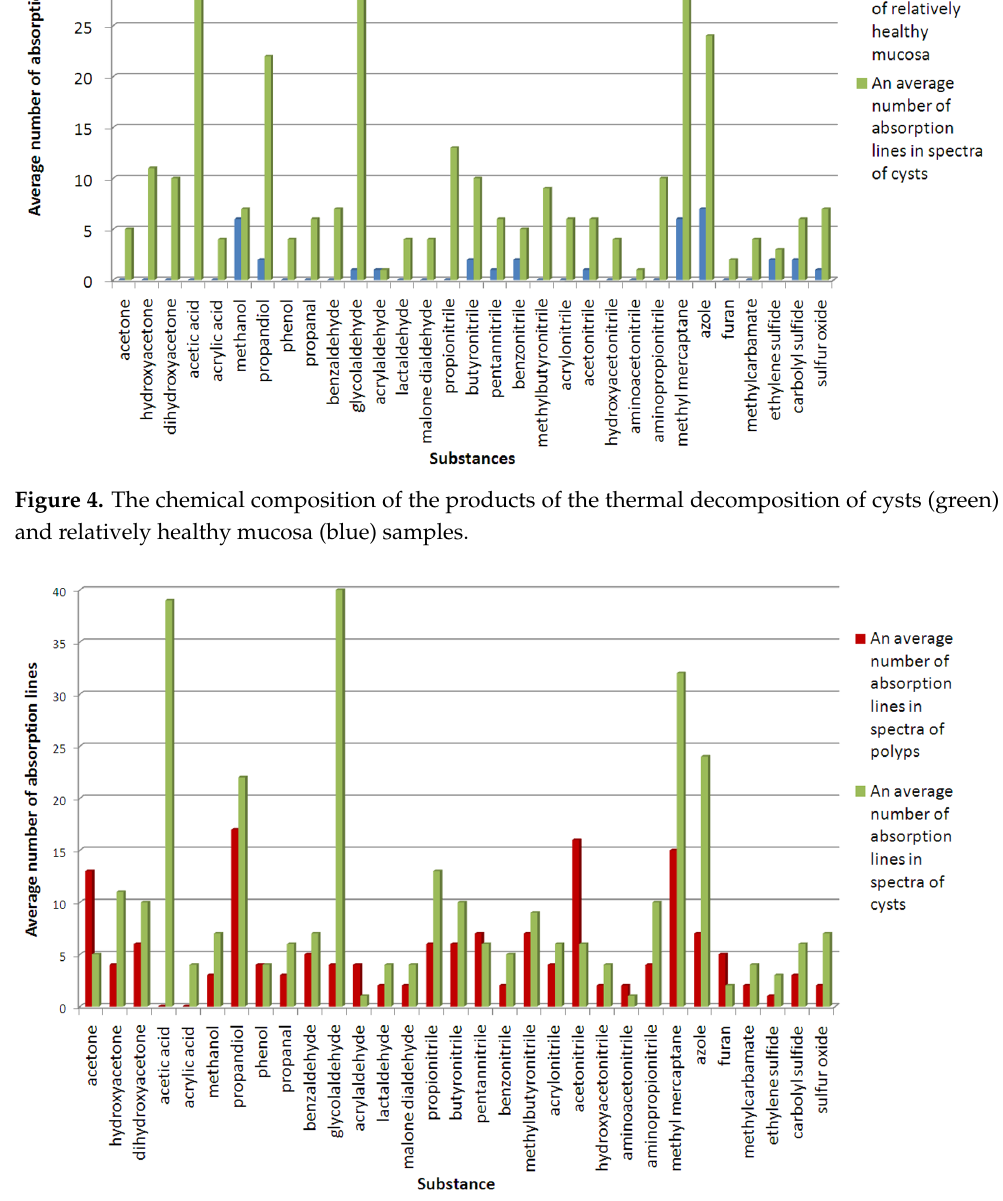
Figure 5. The chemical composition of products of thermal decomposition of cyst (green) and polyp (red) samples.